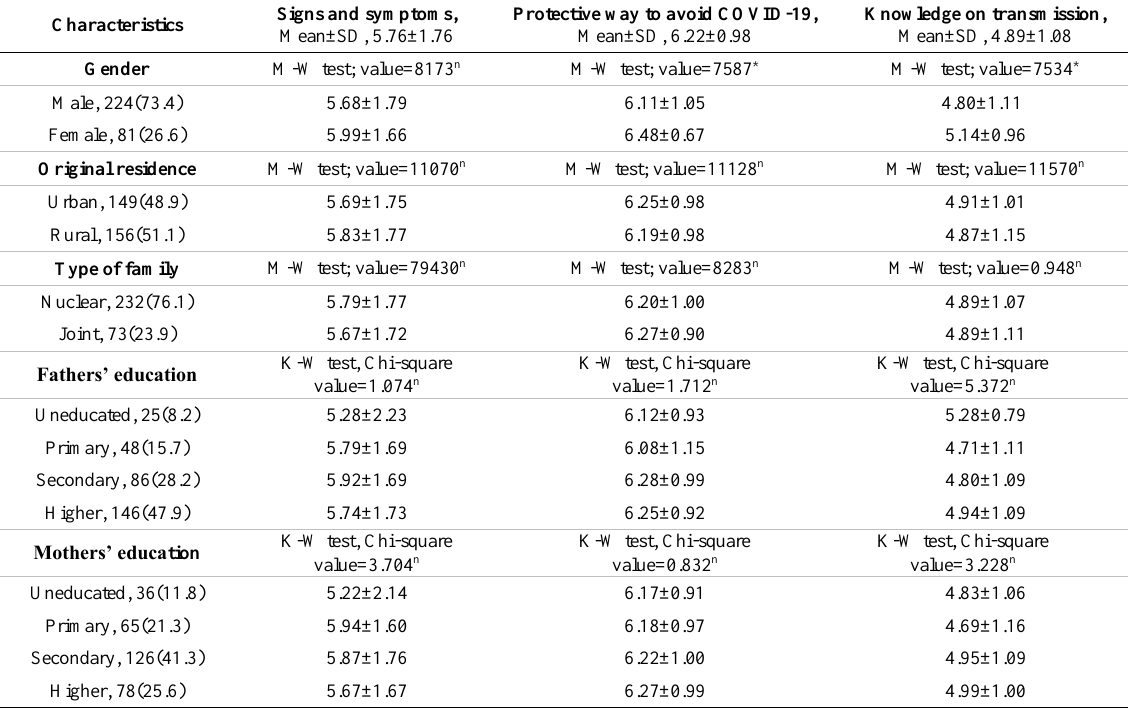
Table 3. Average knowledge on symptoms, protective ways, and the transmission of COVID-19 by different characteristics of